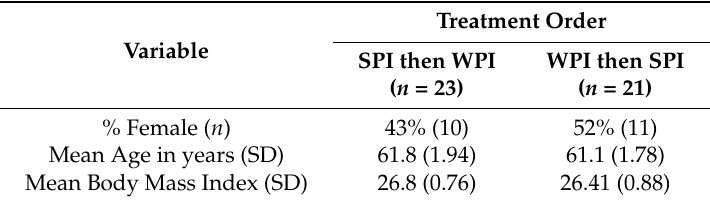
Figure 1. Consort diagram of the intervention trial. Table 1. Baseline characteristics of participants who completed the